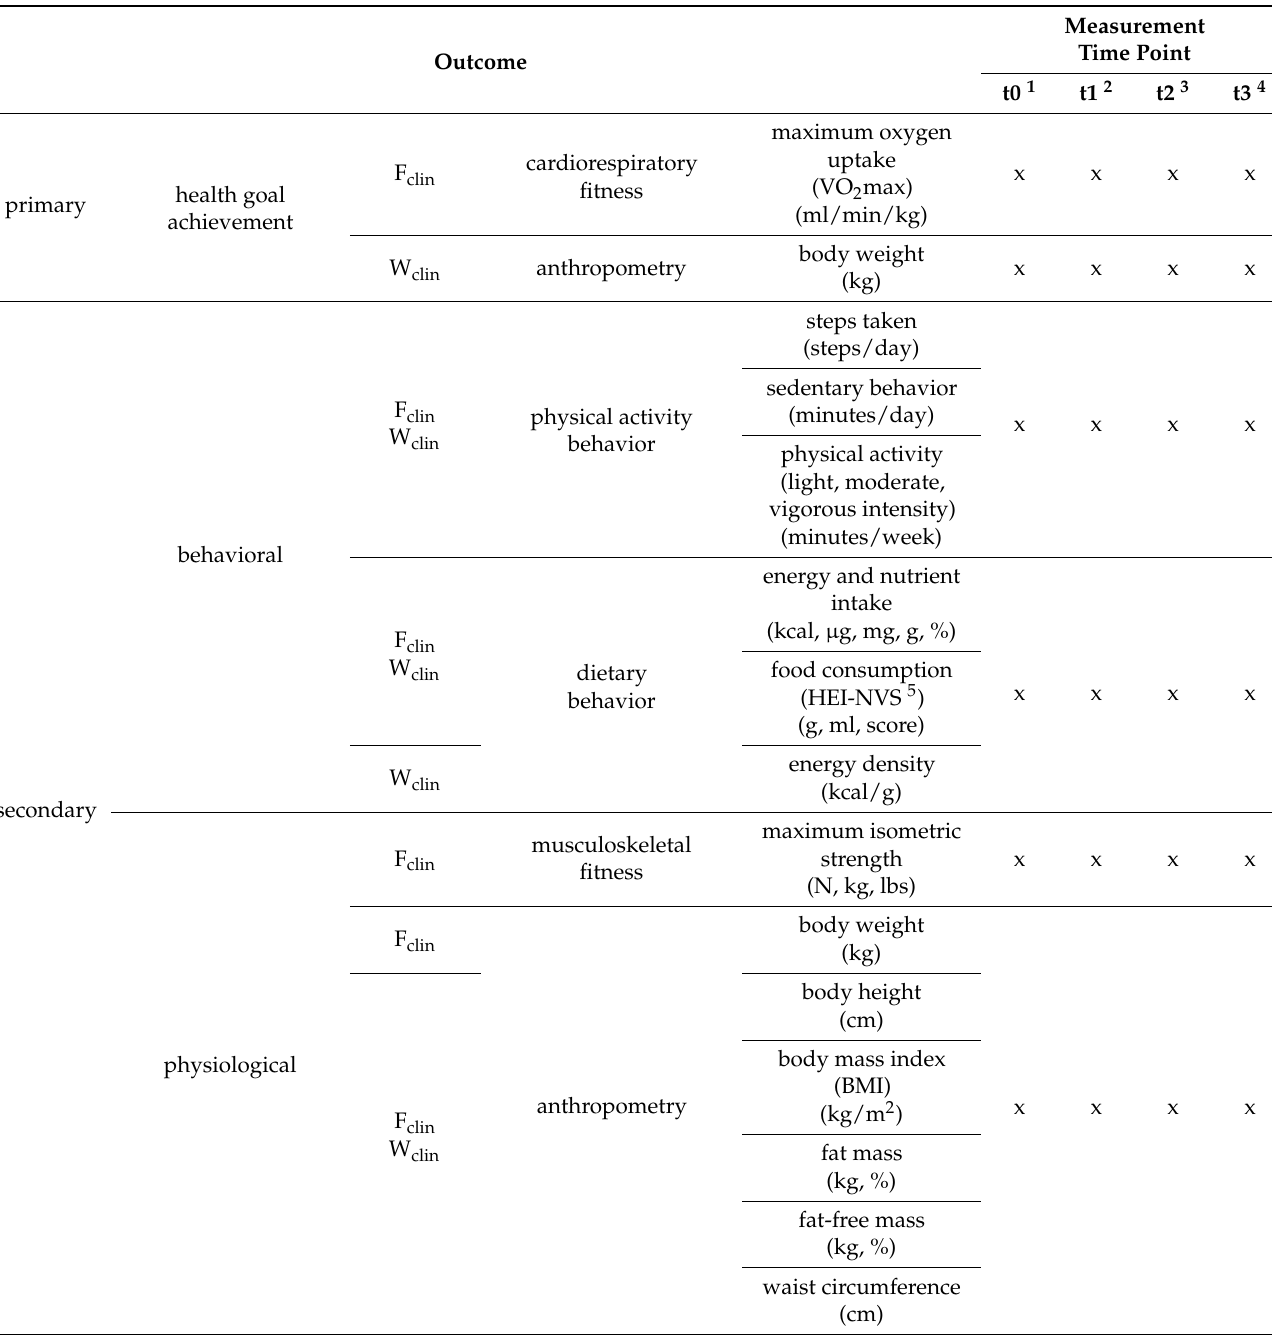
Table 1. Primary and secondary outcomes of the clinical fitness trial (F clin ) and the clinical weight loss trial (W clin